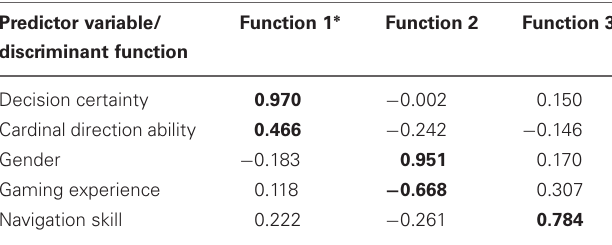
Table 1 | Structure Matrix of Discriminant